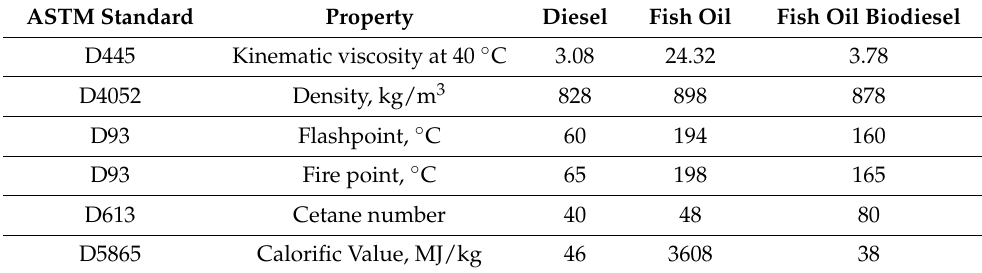
Table 2. Test fuel properties.